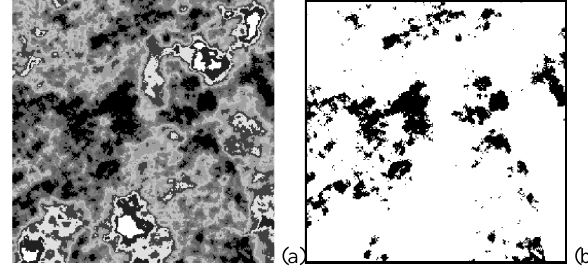
Fig. 3. The obtained results for the K-means method: (a) the image segmented with nine clusters; and (b) the binary image obtained from the segmentation process, where 0 value corresponds to the pore space class and 1 value corresponds to the soil solid class.